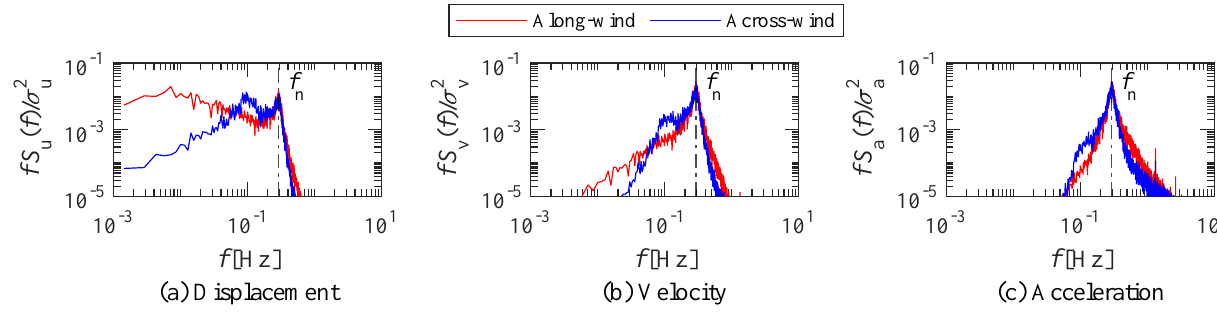
Figure 13. Normalized PSD of wind-induced responses of the FD system